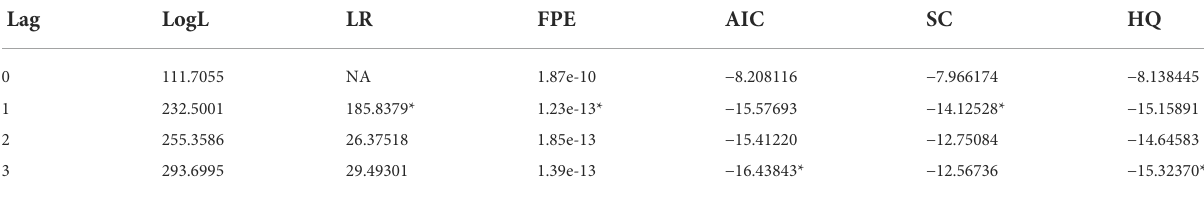
TABLE 3 VAR lag selection